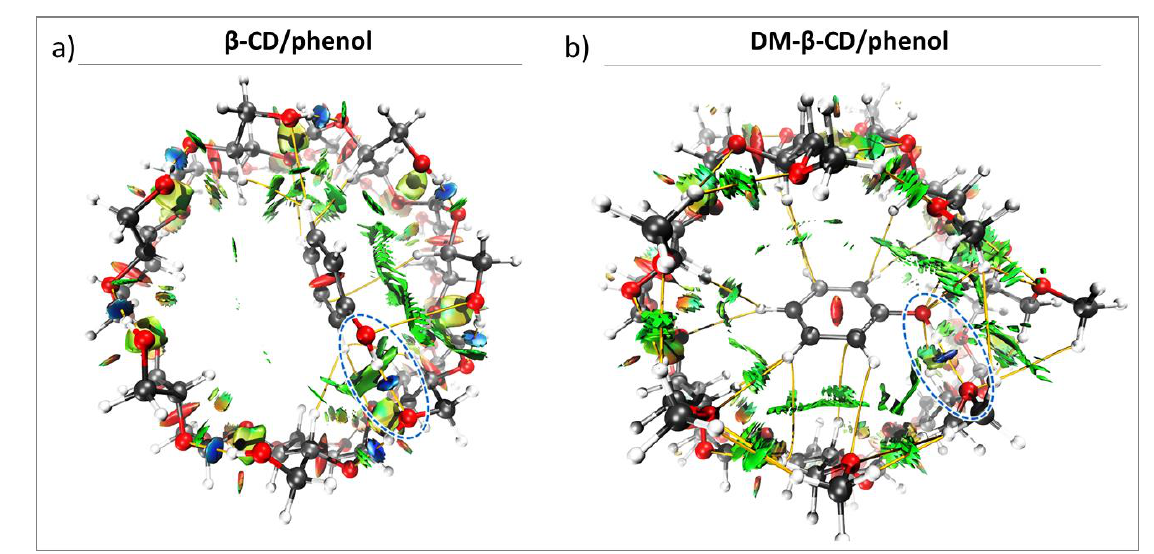
Figure 3. Color-filled RDG isosurface for intermolecular host-guest interactions between ( a ) β -CD /phenol and ( b ) DM- β -CD /phenol. The different types of interaction regions are highlighted in different colors; blue: attractive interactions (hydrogen bonds), green: slightly attractive vdW interactions, red: repulsive steric interactions. Hydrogen bonds between the host and phenol are additionally marked with blue, dashed ellipsoids. Table 2. Binding parameters of CD/phenol host-guest complexes (in